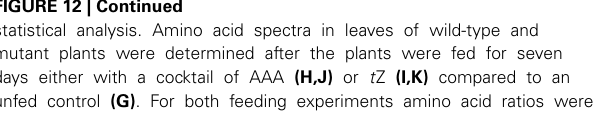
mutant plants were determined after the plants were fed for seven days either with a cocktail of AAA (H,J) or t Z (I,K) compared to an unfed control (G) . For both feeding experiments amino acid ratios were